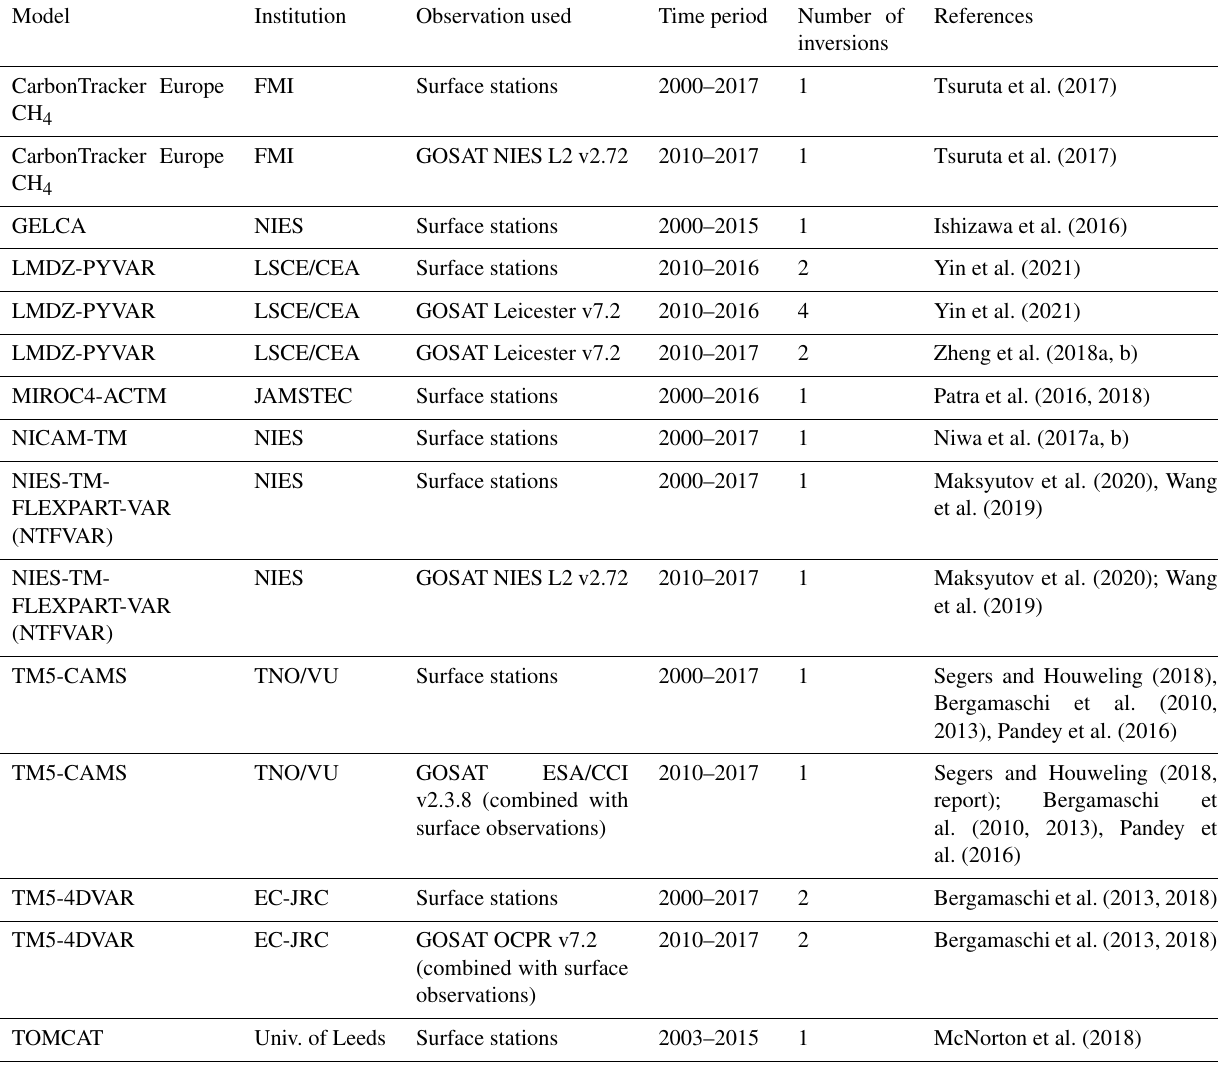
Table B3. Top-down studies used in our new analysis, with their contribution to the decadal and yearly estimates noted. For decadal means, top-down studies have to provide at least 8 years of data over the decade to contribute to the estimate, from Saunois et al.